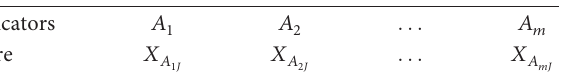
Table 4: Expert scores.